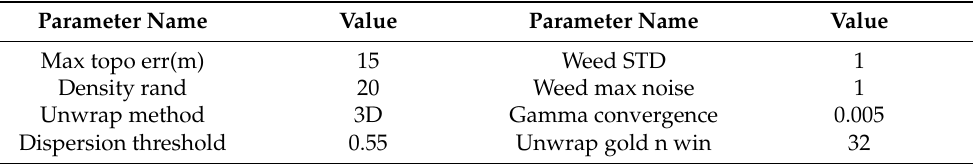
Table 1. Key parameters set in the StaMPS analysis